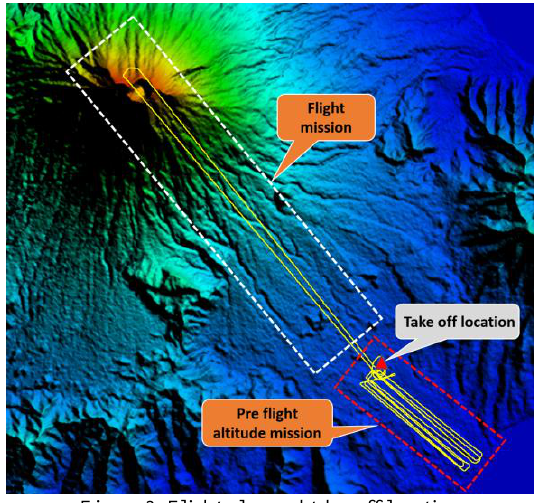
Figure 3. Flight plan and take-off location. Red colour area indicated pre-flight altitude mission.